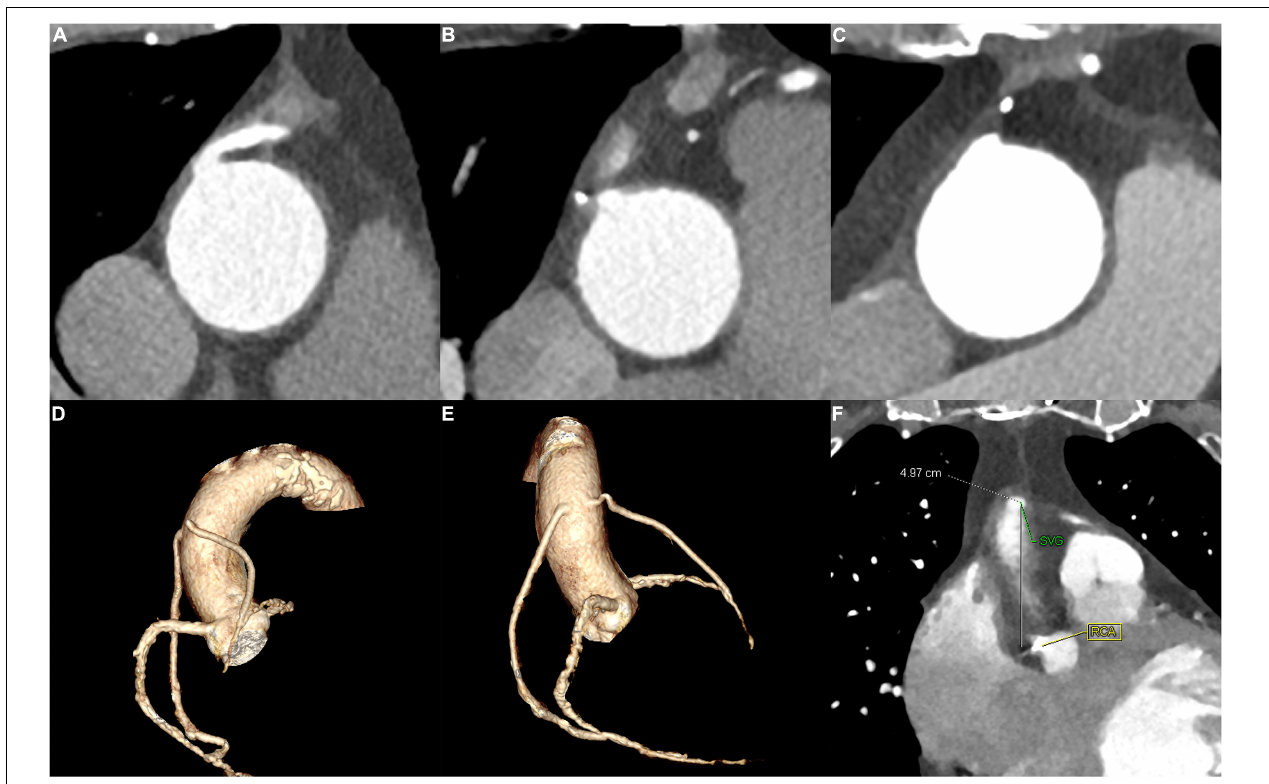
FIGURE 1 | The representative cases for SVG identified by CTA. (A) and (B) A 65–70-year-old patient of the CTA–ICA group who had two SVG. (A) The patency of one SVG and (B) the occlusion of the other SVG. (C) A 60–65-year-old patient who had an incomplete direct ICA and ascending aortography, a subsequent